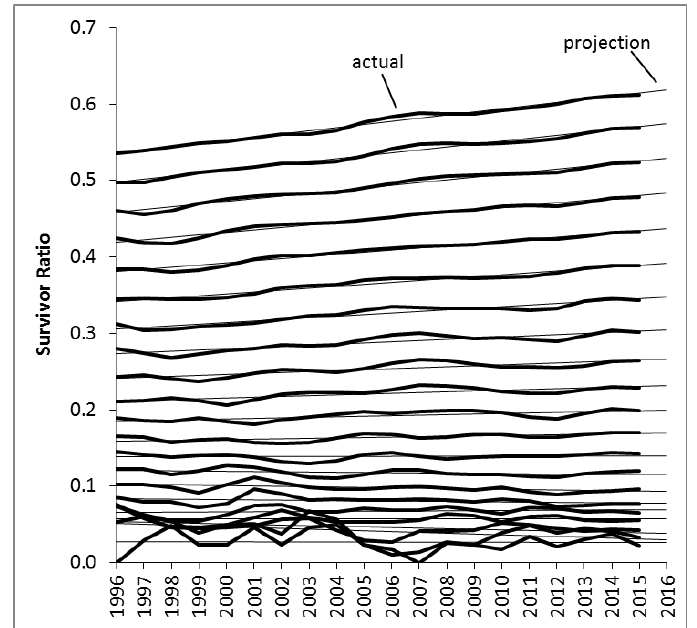
Figure 2: Actual female Survivor Ratios and linear projections, 1996-2016